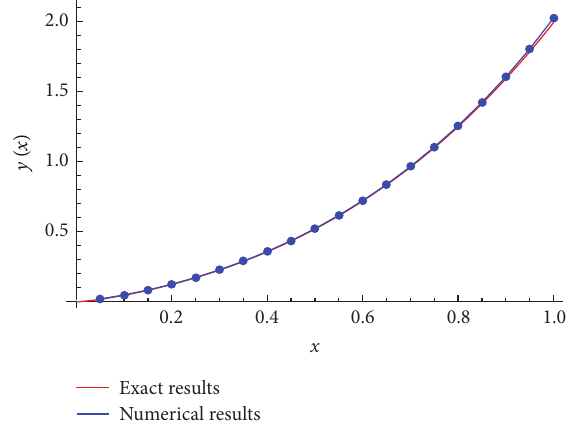
Figure 5: Comparison of the numerical solutions with exact so- lution for n � 8.